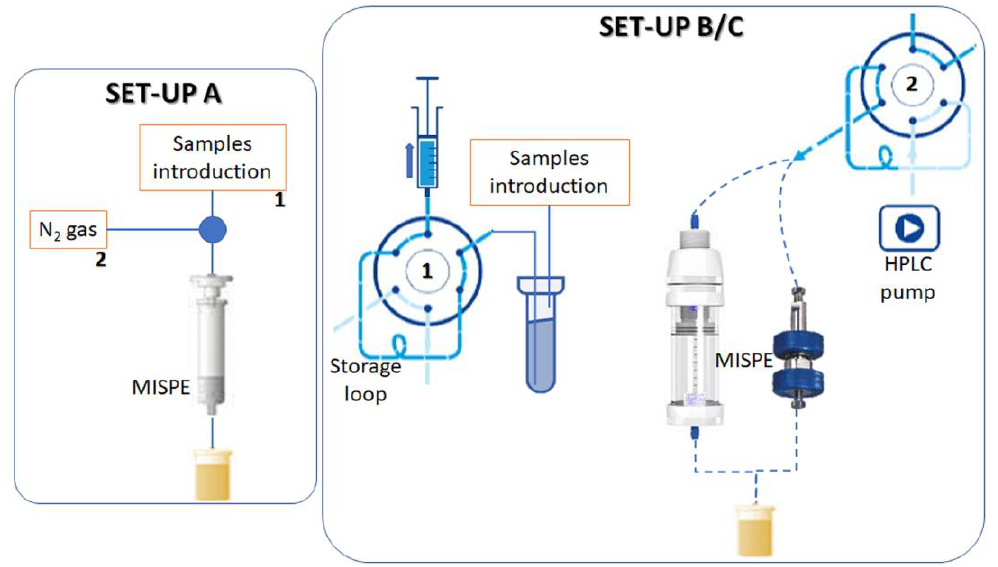
Figure 2. Schematic representation of the 3 set-ups employed. In all set-ups, chemicals are first loaded in the MISPE (step 1 in the scheme) and then eluted out of the MISPE (step 2 in the scheme). Set-up B and C differ from the type of cartridges used to contain the MISPE: Valco fingertight HPLC column ( right , set-up B) and Omnifit glass column ( left , set-up C).